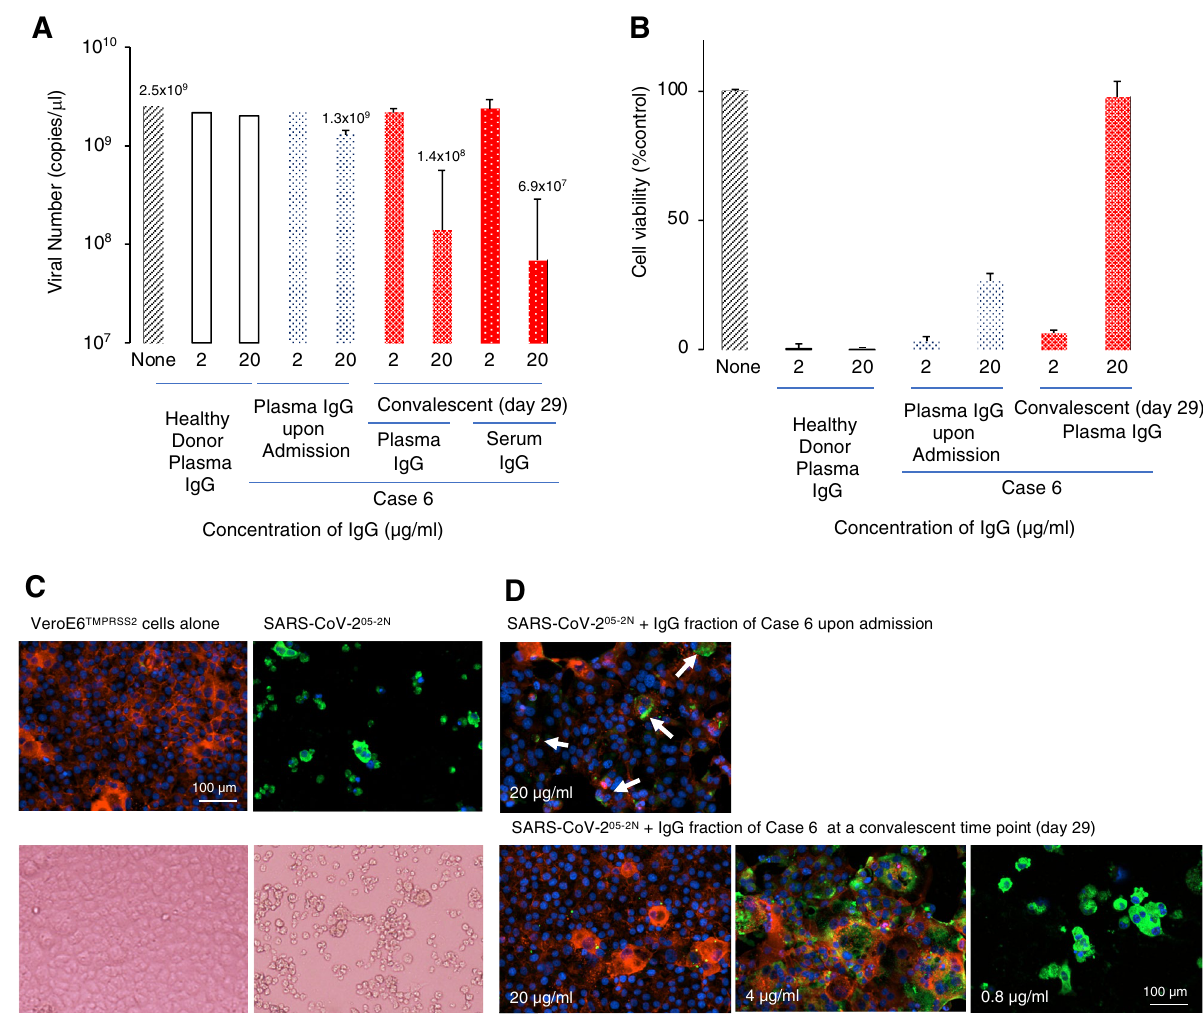
Figure 1. Neutralizing activity of IgG fraction from a representative convalescent patient. ( A ) SARS-CoV- 2 05-2N was mixed with the IgG fraction from a patient (Case 6) or a healthy donor, incubated for 20 min, and then inoculated to VeroE6 TMPRSS2 cells. The infectivity of the virus was examined by determining viral copy numbers using RNA-PCR. ( B ) The inhibition of cytopathic effect of SARS-CoV-2 05-2N in VeroE6 TMPRSS2 cells by the IgG fraction from the plasma of Case 6 or a healthy donor. ( C , D ) Immunocytochemistry of SARS- CoV-2 05-2N -infected VeroE6 TMPRSS2 cells. The IgG fraction (20 µg/ml) from Case 6 completely blocked the infectivity and cytopathic effect of SARS-CoV-2 and no cells got stained in green. Upper and lower insets in Panel ( D ) represent merged images, which are composed of images obtained from 3-color fluorescence. Viral antigens, actin filaments, and nuclei are indicated in green, red, and blue. The upper inset in ( D ) shows that most VeroE6 TMPRSS2 cells were protected by the IgG fraction (20 µg/ml), while a few cells were infected (indicated by arrows). Lower right panel shows that the structure of actin filaments was totally destroyed by SARS-CoV-2 05-2N infection and almost all the cells got stained in green (SARS-CoV-2-positive); however, 20 µg/ ml of the IgG fraction from Case 6 completely blocked the infectivity and cytopathicity of the virus. Images of immunocytochemistry were obtained using Cytation5 (BioTek,